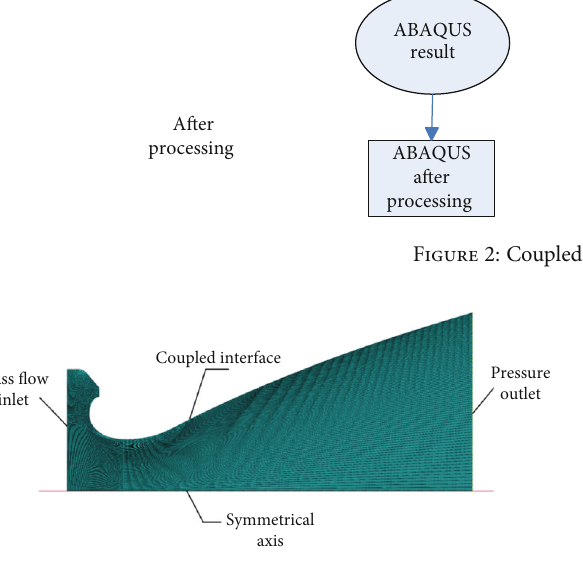
Figure 3: Fluid domain calculation model.